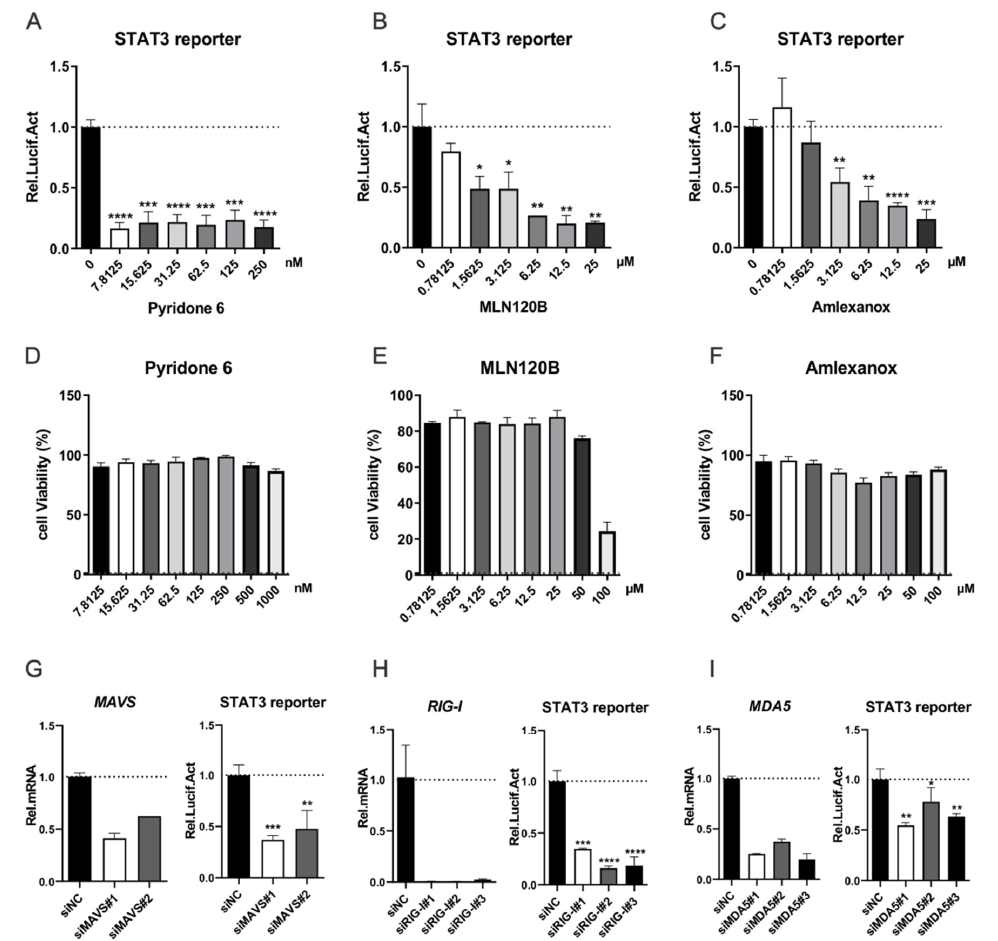
Figure 5. The activation of the STAT3 signaling pathway by Lp is mediated by the RIG-I-like signaling pathway. ( A ) Pan-JAK inhibitor Pyridone 6 inhibits the activation of STAT3 induced by LCMV Lp. HEK-293T cells in a well of a 24-well plate were co-transfected with 480 ng of pCAGGs-LCMV-Lp and 20 ng STAT3 reporter plasmids. At 6 h post transfection, cells were treated with the indicated concentration of Pyridone 6. At 36 h post transfection, the cells were lysed to measure the STAT3 reporter activity using a luciferase assay. ( B ) IKK- β inhibitor MLN120B inhibits the activation of STAT3 induced by LCMV Lp. HEK-293T cells in a well of a 24-well plate were co-transfected with 480 ng of pCAGGs-LCMV-Lp and 20 ng of STAT3 reporter plasmids. At 6 h post transfection, cells were treated with the indicated concentration of MLN120B. At 36 h post transfection, the cells were lysed to measure the STAT3 reporter activity using a luciferase assay. ( C ) TBK1 and IKK- ε inhibitor Amlexanox inhibits the activation of STAT3 induced by LCMV Lp. HEK-293T cells in a well of a 24-well plate were co-transfected with 480 ng of pCAGGs-LCMV-Lp and 20 ng of STAT3 reporter plasmids. At 6 h post transfection, cells were treated with the indicated concentration of Amlexanox. At 36 h post transfection, the cells were lysed to measure the STAT3 reporter activity using a luciferase assay. ( D – F ) The effect of Pyridone 6, MLN120B, and Amlexanox on the viability of HEK-293T cells. ( G – I ) The effect of the knockdown of RIG-I, MDA5, or MAVS on the acti- vation of STAT3 mediated by LCMV Lp. HEK-293T cells in a well of a 24-well plate were trans-transfected with the indi- cated siRNAs. At 24 h post transfection, cells were transfected with 20 ng of STAT3 reporter plasmid and 480 ng of pCAGGs-LCMV-Lp. Thirty-six hours later, the cells were collected. Intracellular RNA was extracted and the intracellular level of RIG-I, MDA5, or MAVS was measured using qRT-PCR (left). For luciferase assay, cells were collected and the intracellular level of STAT3 reporter activity was measured (right). A representative from at least three independent ex- periments is shown. Graphs show mean ± SD. ( n = 3, A – I ). * p < 0.05, ** p < 0.01, *** p < 0.001, **** p < 0.0001,unpaired Student’s t -test.